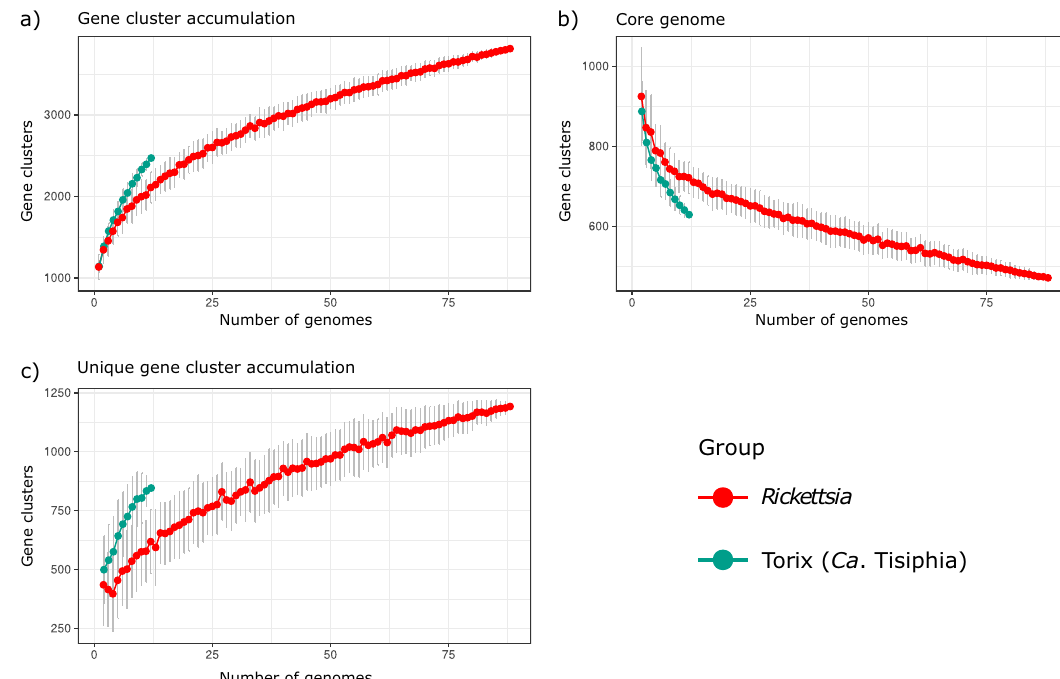
Fig. 4 Gene cluster accumulation analysis. a Pangenome accumulation curves. b Core genome accumulation curves. c The unique genome of Rickettsia (red) and Torix (turquoise) clades as a function of the number of genomes sequenced. Each point represents the mean value while error bars represent ± standard deviation based on 100 permutations. Source data are provided in Source